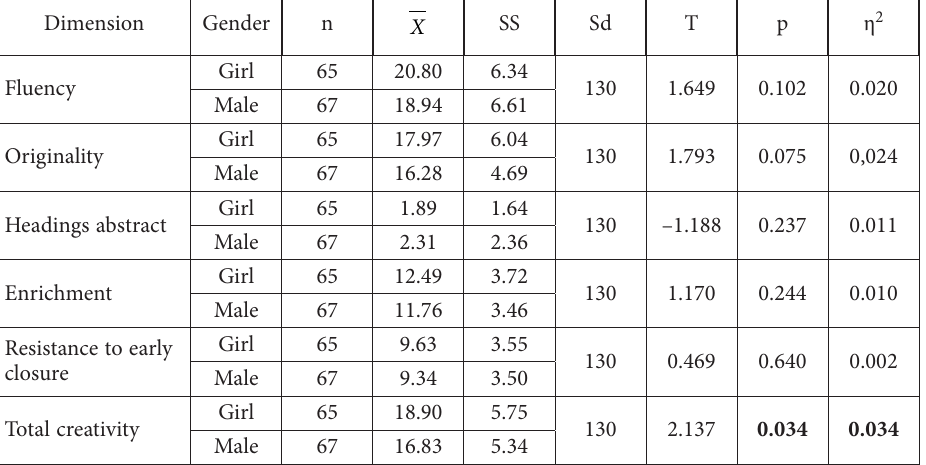
Table 5. Results of the T-Test of creativity points of the participating children in the fifth grade (source: created by author) Dimension Gender